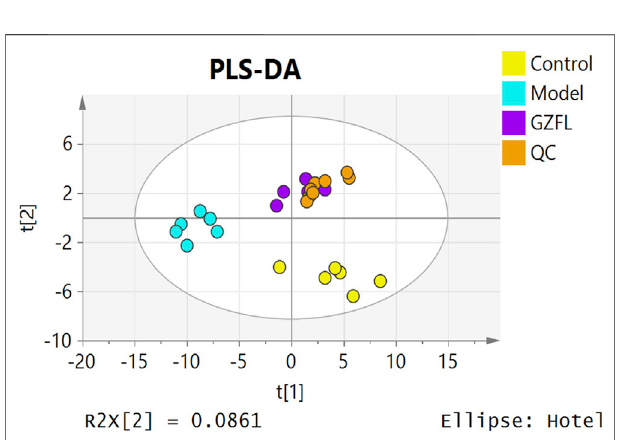
FIGURE 5 | PLS-DA score plot of uterine tissue samples from three test groups (Control, Model, GZFL) and quality control (QC).